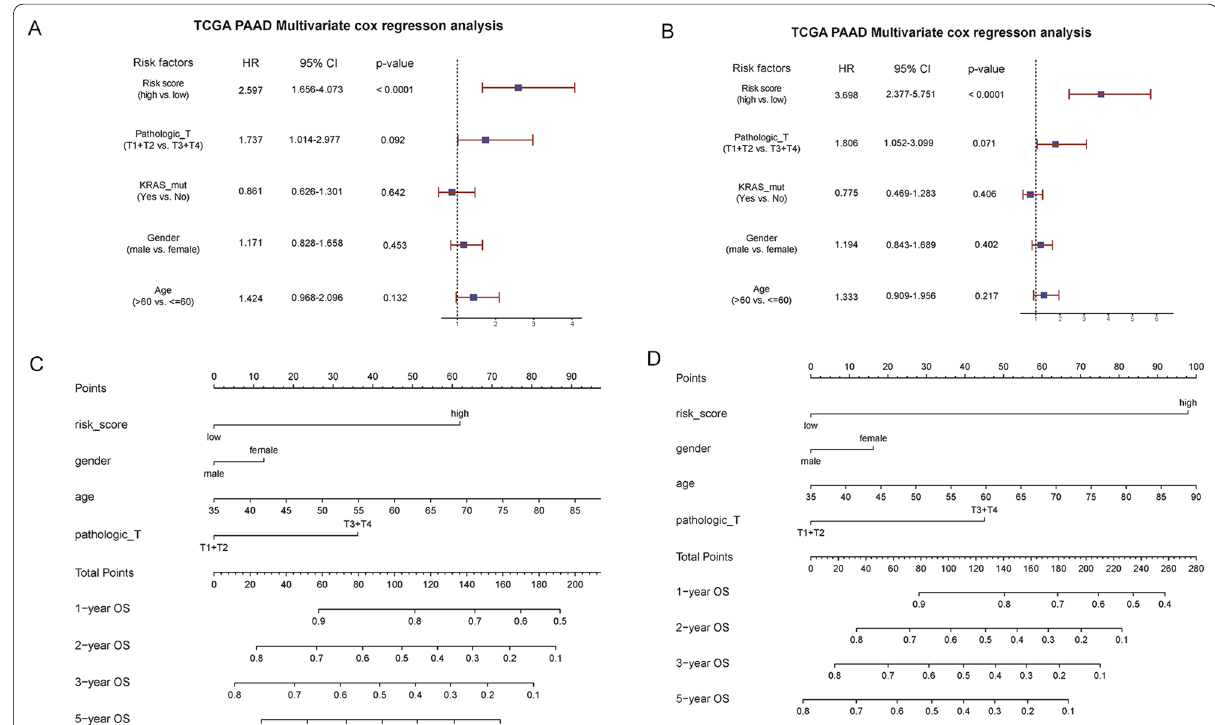
Fig. 8 ( A mRNA, B lncRNA) Results of multivariate Cox regression analysis. Forest plot of the multivariable Cox regression analysis. The squares on the transverse lines present the hazard ratio (HR), and the transverse lines represent the 95% confidence interval (CI); ( C mRNA, D lncRNA) nomogram of the overall survival prediction in